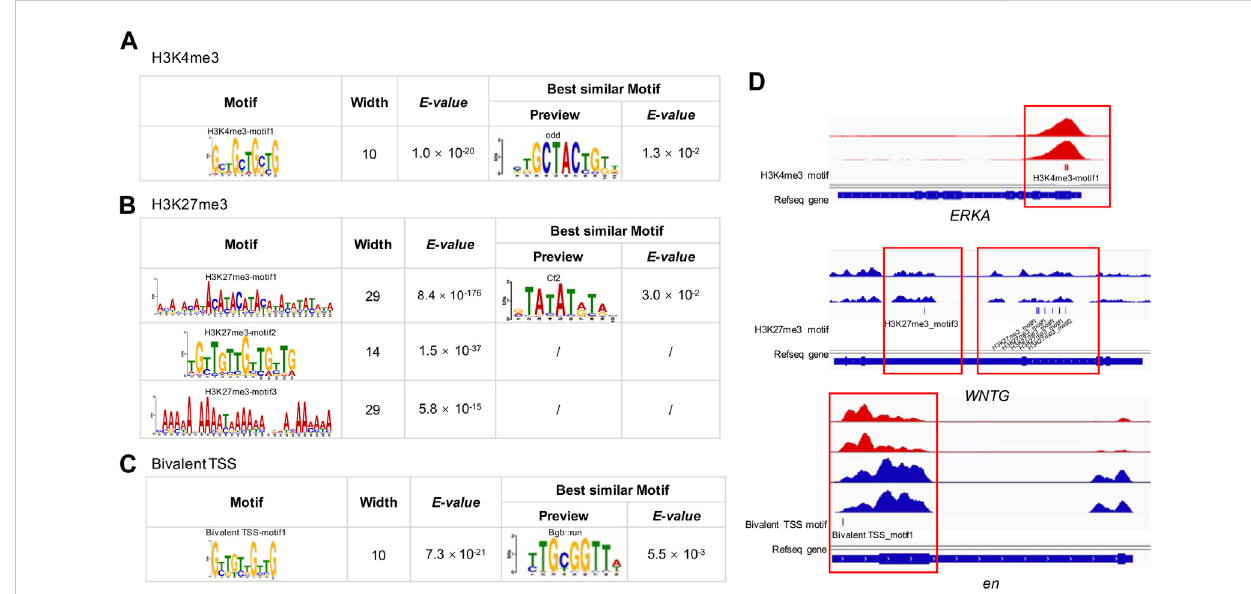
FIGURE 5 MEME-CHIP analysis of H3K4me3, H3K27me3 and bivalent domains motif in the B. dorsalis genome. Top consensus sequences identi fi ed by de novo motif discovery for (A) H3K4me3, (B) H3K27me3 and (C) bivalent TSSs, and the best similar known motifs previously described in Drosophila .